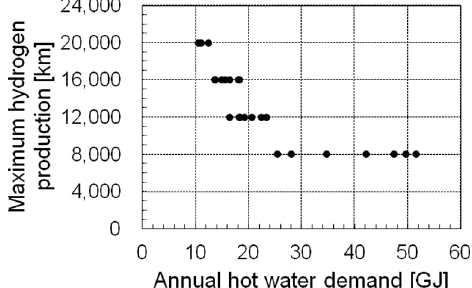
Fig. 7. Relationship between hydrogen production and hot water